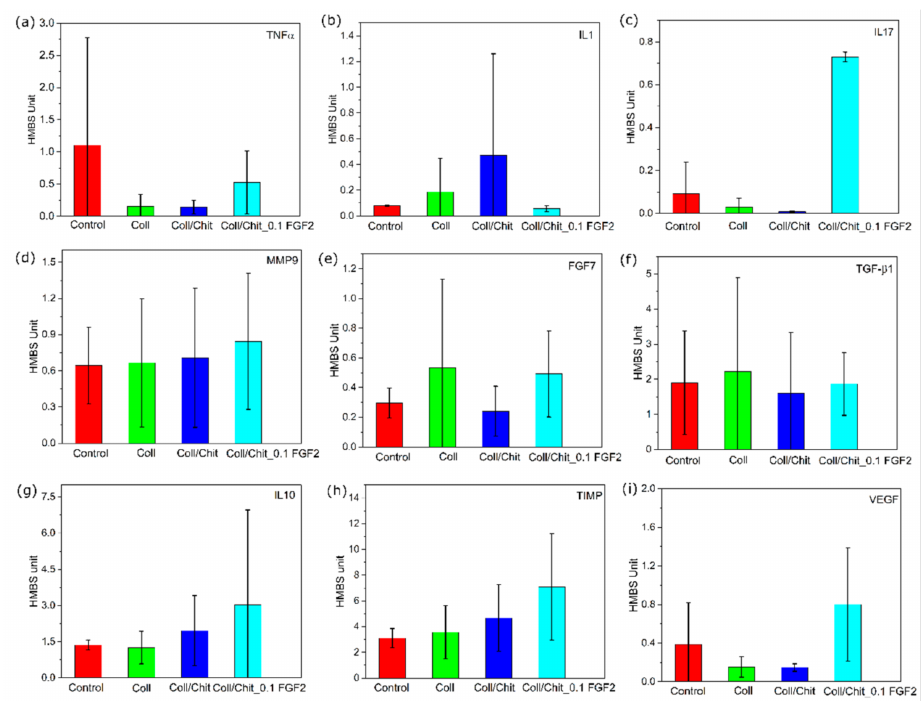
Figure 16. Expression of mRNA of cytokines: ( a ) TNF α ; ( b ) IL1; ( c ) IL17; ( d ) MMP9; healing proteins ( e ) FGF7 and ( f ) TGF- β 1; ( g ) anti-inflammatory cytokine interleukin 10 (IL10); ( h ) tissue inhibitors of metalloproteinases (TIMP-1); ( i ) vascular endothelial growth factor (VEGF) of sites treated with scaffolds compared to non-treated control site at post-operative day 21. Results are expressed as relative mean ± SD of HMBS (house-keeping gene) units. No statistical